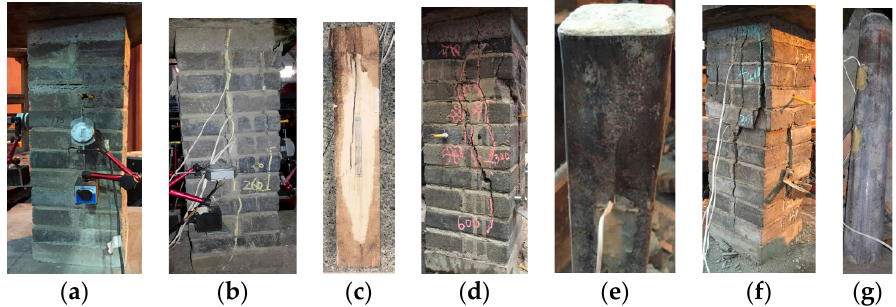
Figure 6. Failure states of RCB1–RCB4: ( a ) RCB1; ( b ) RCB2; ( c ) square-shaped wood; ( d ) RCB3; ( e ) square-shaped steel pine; ( f ) RCB4; and ( g ) circular steel